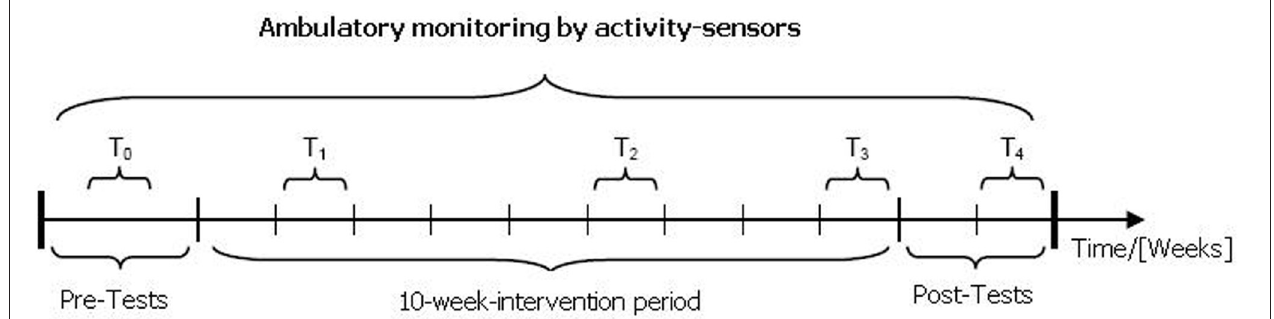
FIGURE 1 | Study design (Test of aerobic endurance capacity at T0 and T4, assessment of activity and mood at